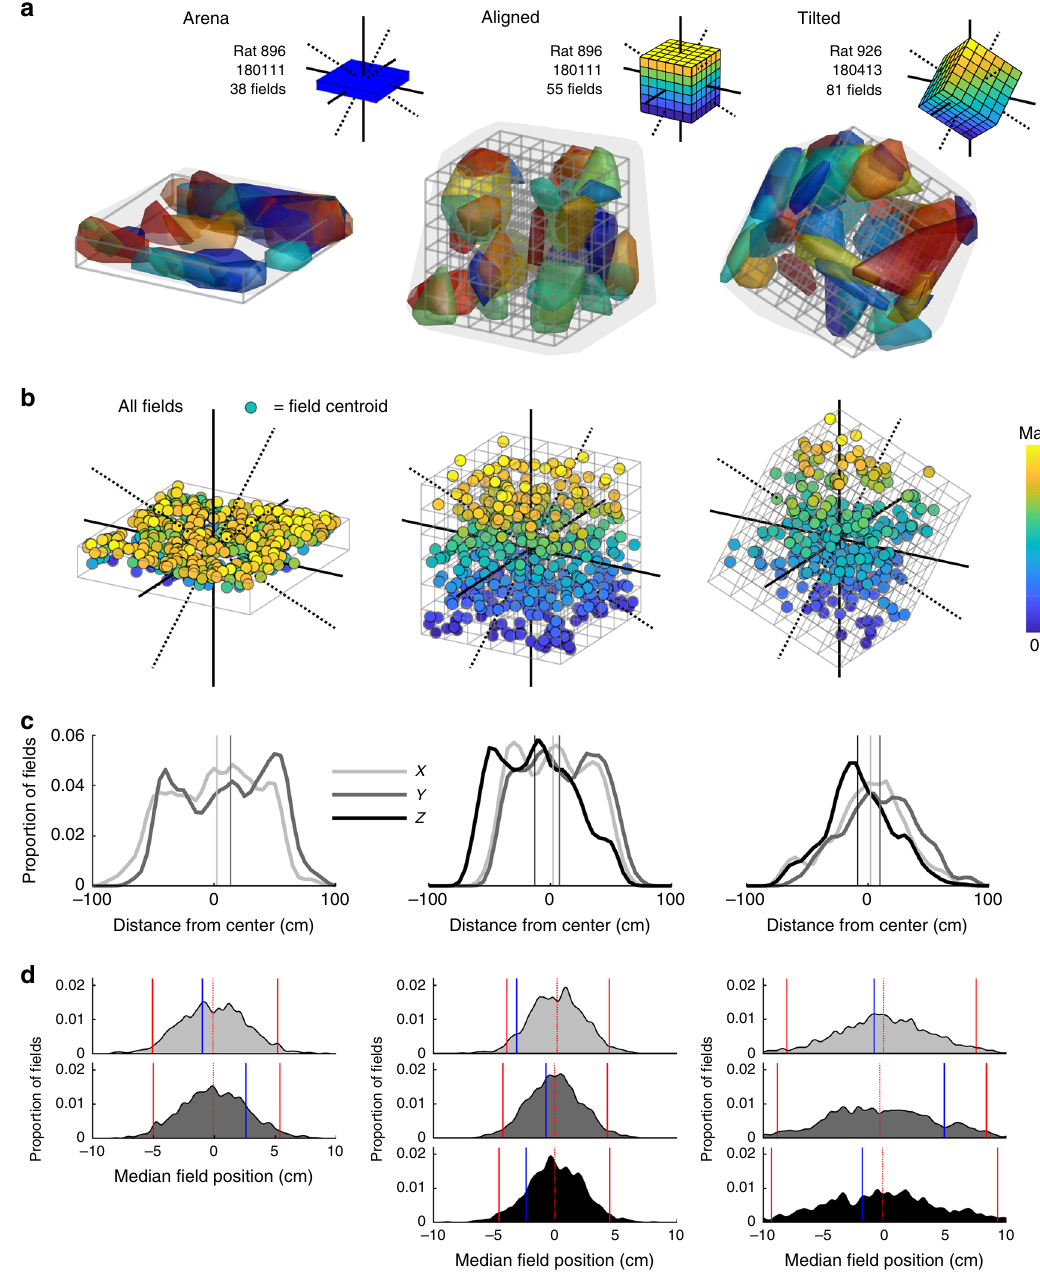
Fig. 5 Place fi elds were distributed throughout the three mazes. Source data are provided as a Source Data fi le. a Representative arena, aligned and tilted lattice recording sessions demonstrating homogenous distribution of fi elds. To allow clearer distinction of separate (color-coded) fi elds, only fi elds with a volume less than 300 voxels (one voxel = 50 mm cube) are shown (~2/3 total). Inset schematics show the maze orientation and axes. b Location of all recorded place fi eld centroids. Colors denote vertical position. c Columns follow the mazes as above; the kernel smoothed distribution of place fi elds along the X , Y and Z dimensions of each maze ( Z is not shown for the arena) relative to the maze center. Vertical lines represent the median value of these distributions. d Columns follow the mazes as above; from top to bottom graphs show the results of a shuf fl e analysis on the distribution of fi elds along the X , Y and Z axes ( Z is not shown for the arena). Blue lines denote the median position of real place fi elds along these axes relative to the maze center. Shaded areas represent the distribution of median values obtained from 1000 shuf fl es. Red lines show the 2.5 and 97.5 percentile rank positions in the shuf fl ed distributions, red dotted lines denote the 50th percentile rank or median of the shuf fl e